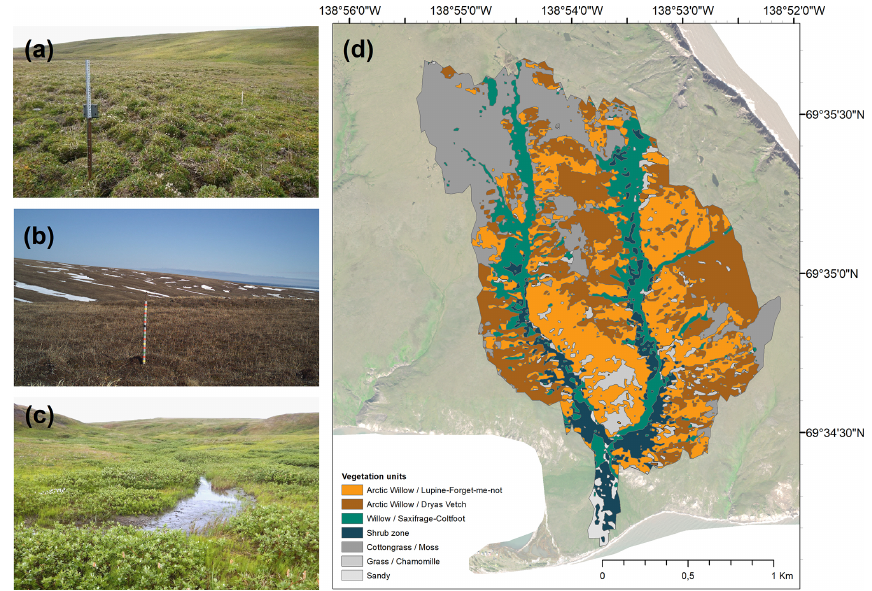
Figure 3. Vegetation classes occurring in the Ice Creek catchment: (a) irregular and hummocky terrain observed in Lupine class (credit: Michael Fritz), (b) low vegetation in well-drained areas (such as Dryas) (photo by the authors), and (c) shrub and wetland (such as Coltsfoot class) (credit: Michael Fritz). (d) Vegetation unit’s distribution in the study area (from Obu et al., 2017) as defined initially by Smith et al. (1989). The classes in grey are not included in the